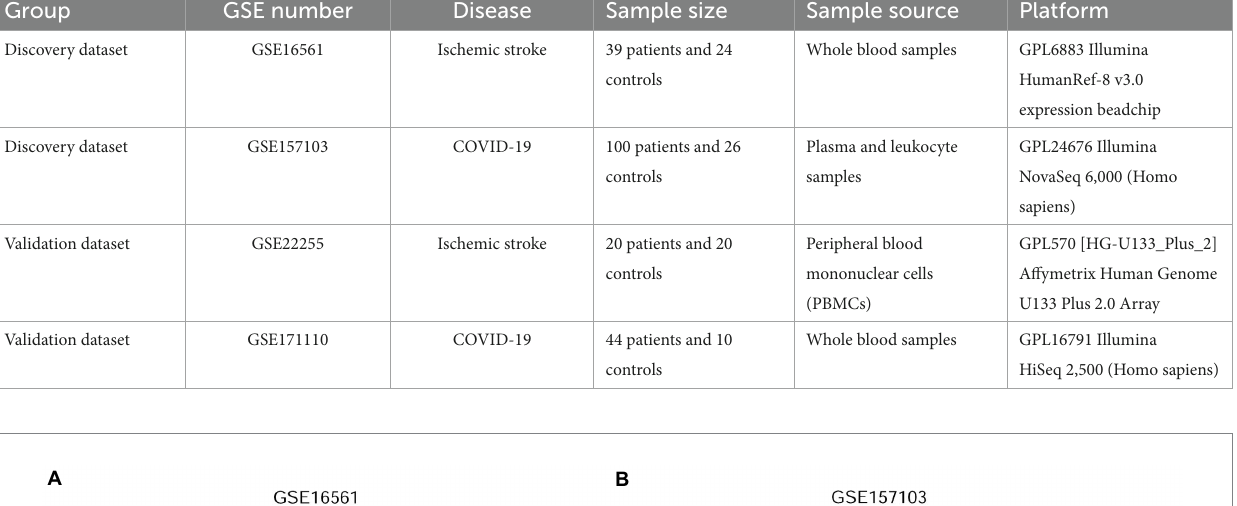
TABLE 1 Information of four GEO datasets associated with ischemic stroke and COVID-19. Group